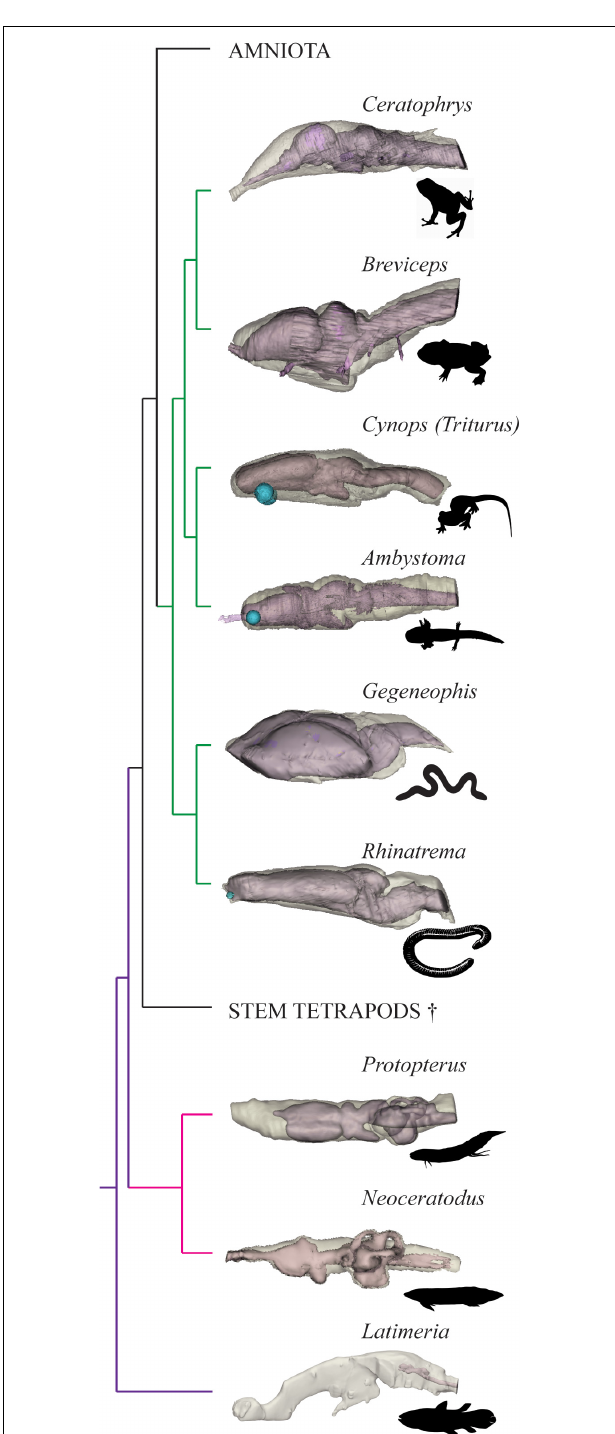
FIGURE 3 | Brain-braincase relationship in extant piscine sarcopterygians and select Lissamphibian taxa. Endocasts (light brown) shown in transparent overlay on brains (pink) in left lateral view. Latimeria, Neoceratodus, Protopterus, Ambystoma , and Cynops from Challands et al. (2020), phylogeny adapted from Amemiya et al. (2013) and Pyron and Wiens (2011). Images not to scale. Gegeneophis silhouette drawn by AMC, all other animal silhouettes from http://phylopic.org, see Acknowledgments for individual image